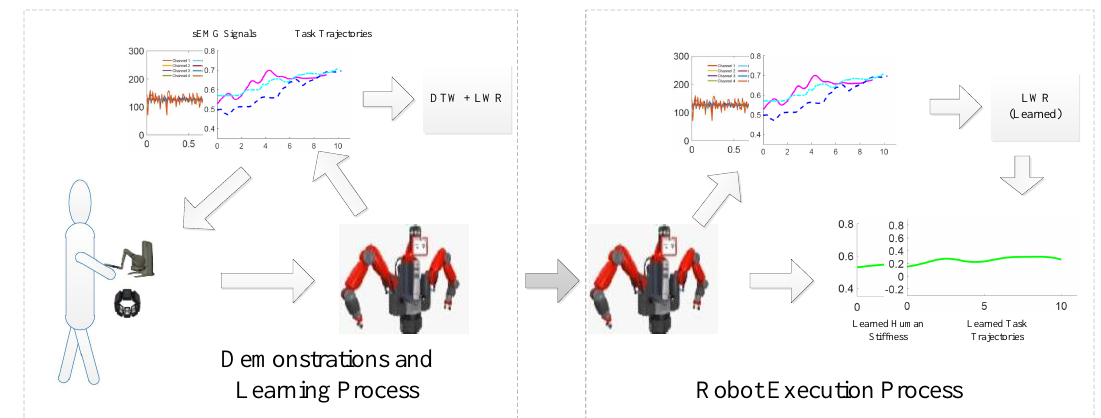
Figure 6. Experiment process of the proposed method.